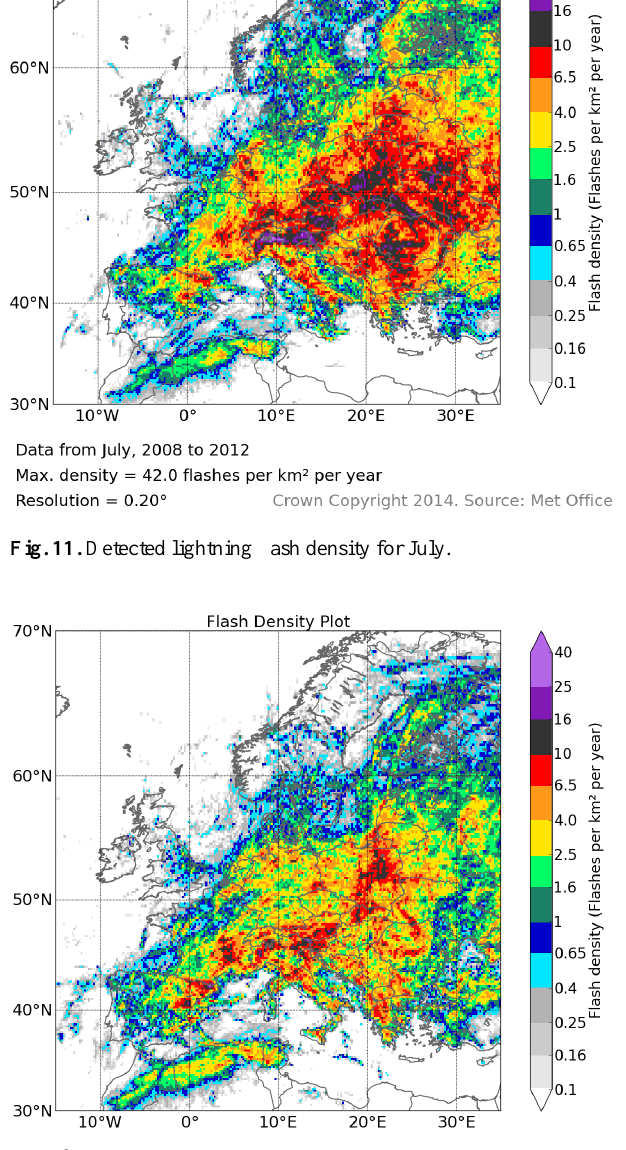
European lightning densities now observed in Poland and Ukraine.